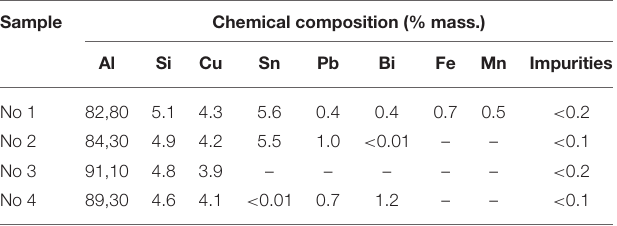
TABLE 1 | The chemical composition of the investigated alloys.